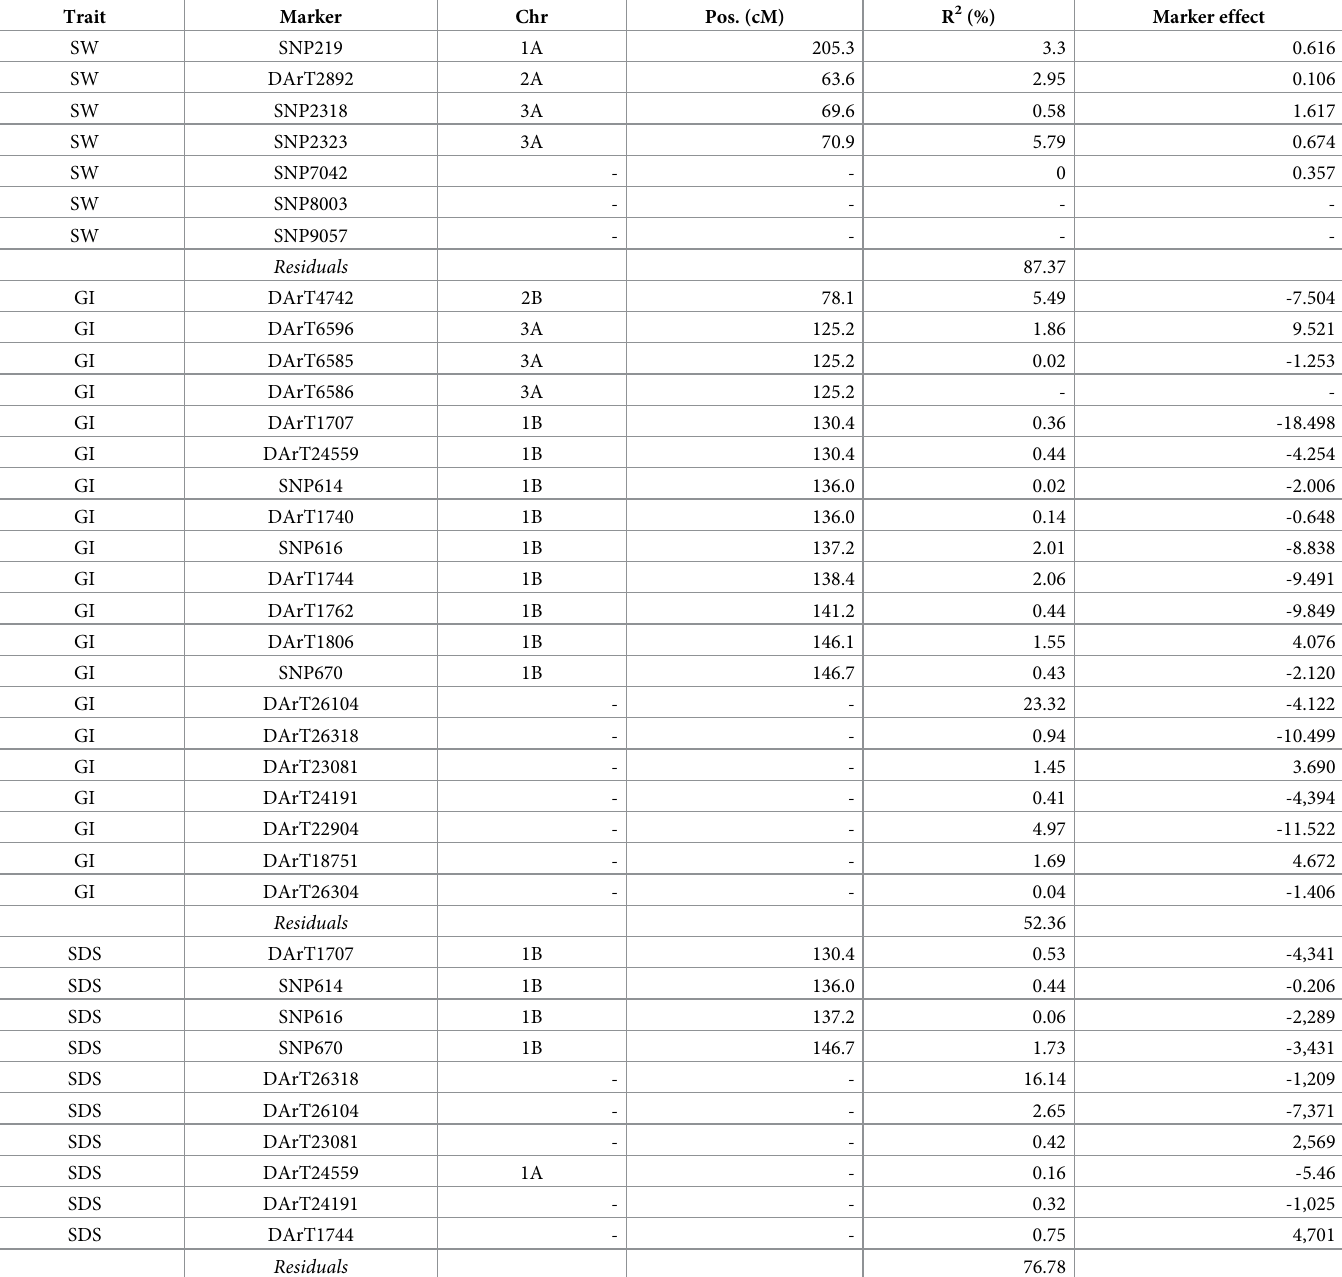
Table 3. Marker-trait associations found for quality